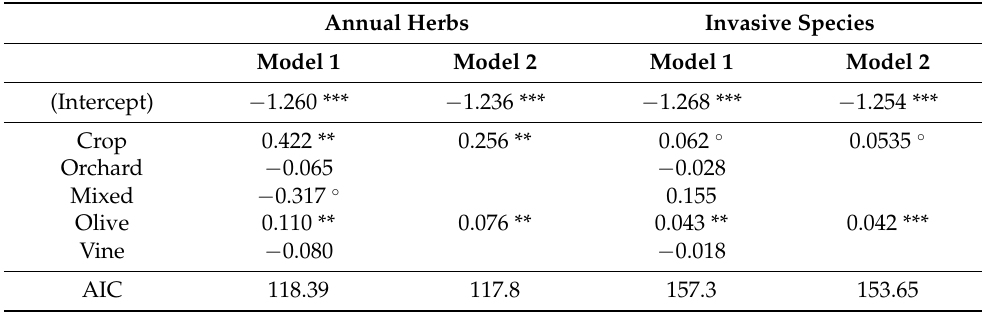
Table 6. Presence of annual herbs and alien species explained by agricultural categories of land-use. Coefficients of two generalized linear models (Binomial distribution) fitted to all variables (Model 1) and only statistically significant variables (Model 2). Statistically significant values are indicated